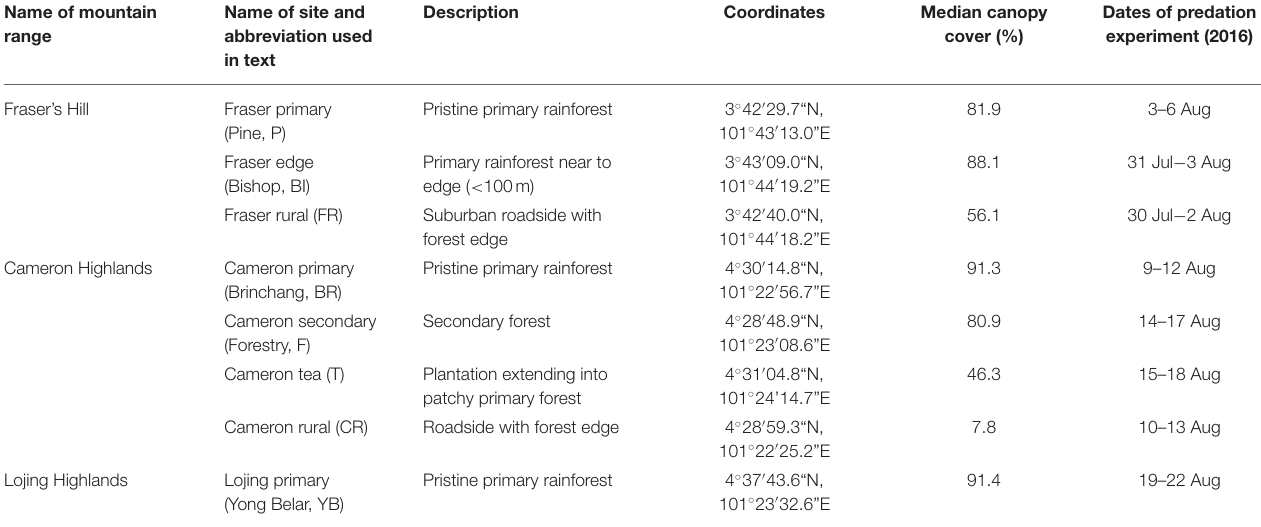
TABLE 1 | Summary of information on study sites for predation experiments from July to August 2016 including the names of the mountain ranges and sites and abbreviation used in the text; description of the habitat type; the geographical coordinates of the site, the median canopy cover of the sites; and the dates of the predation